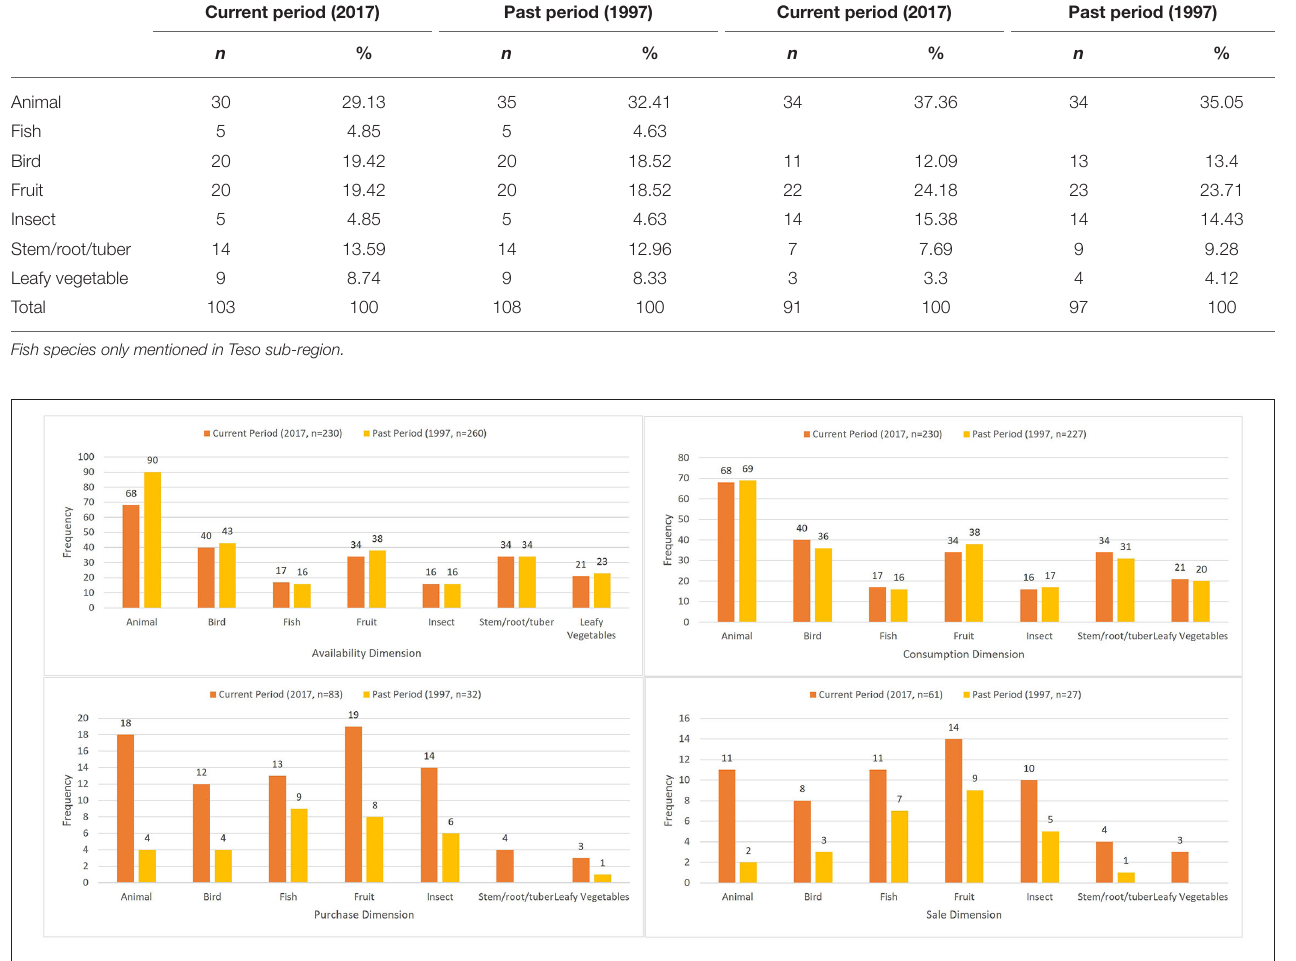
FIGURE 6 | Frequency of wild species according to the 4-dimension in Teso sub-region (availability, consumption, purchase, and sale) ( Supplementary Table 2